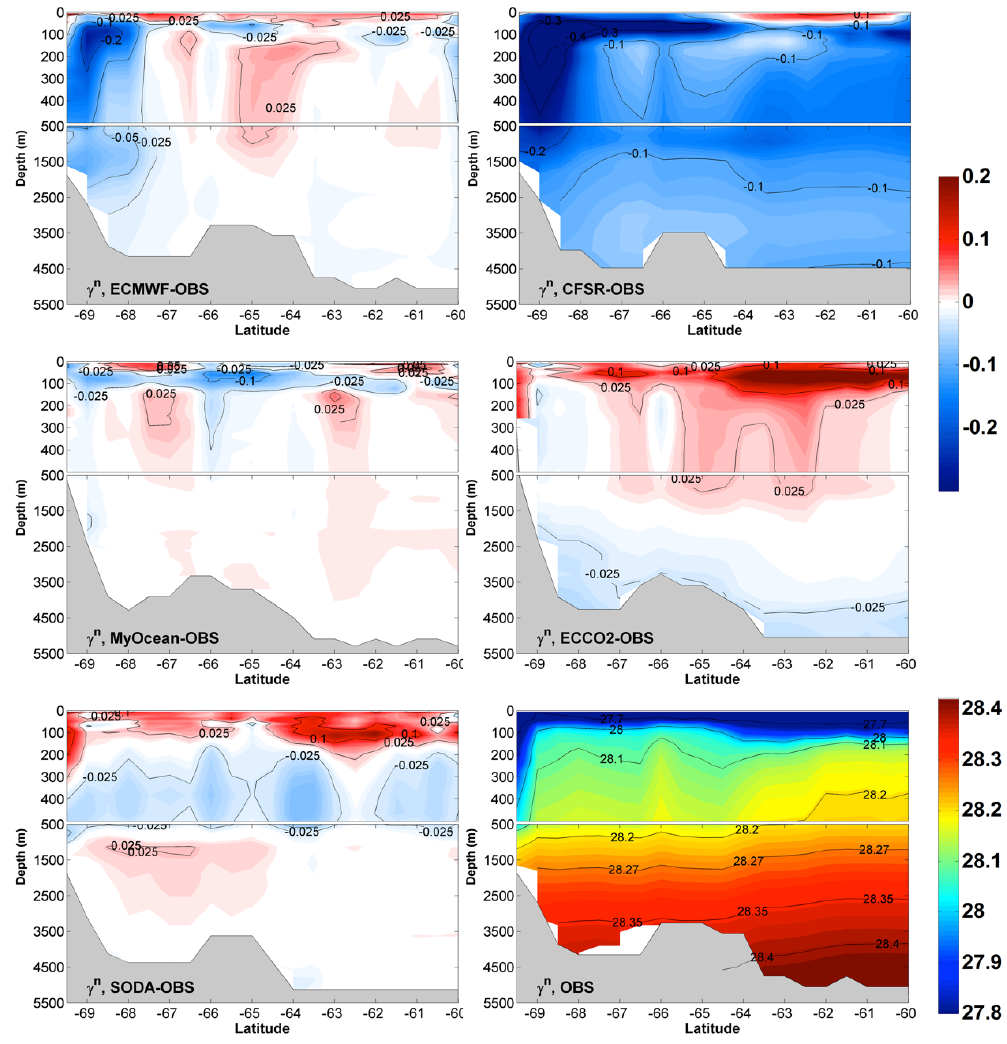
Figure 8. Section WOCE A12. Representation of the time-averaged in situ data and the differences between the reanalyzed and observed data for γ n . ECMWF, CFSR, MyOcean, ECCO2, and SODA results are indicated in each figure. The upper 500m is expanded to show more detail.